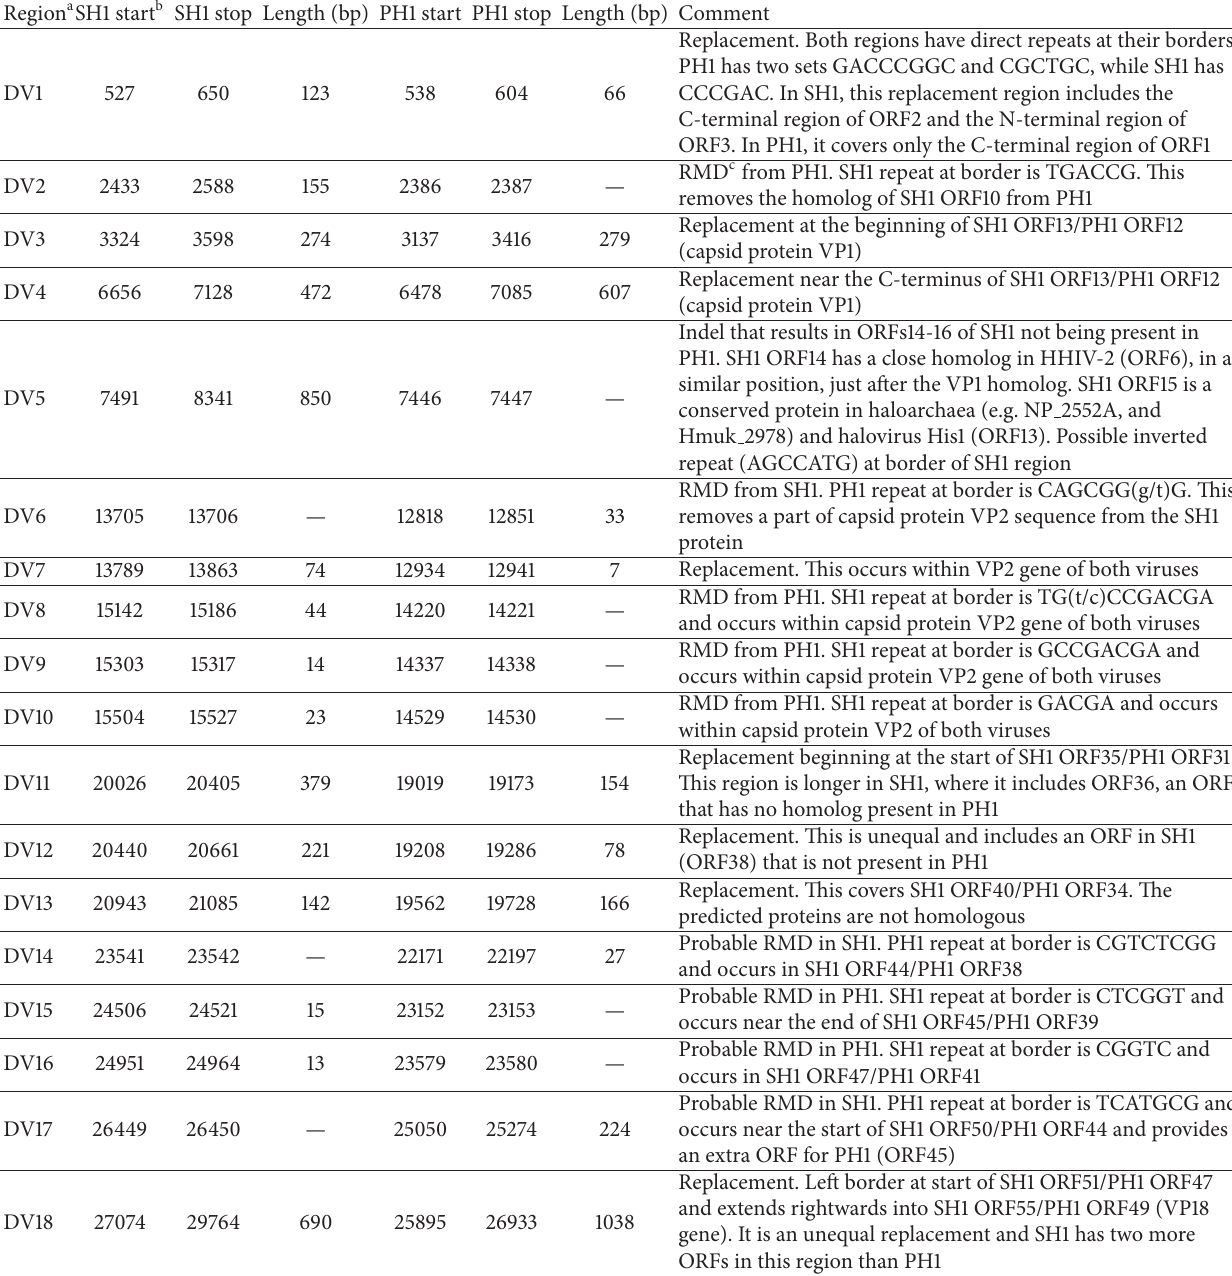
Table 5: Main differences (divergent regions) between the SH1 and PH1